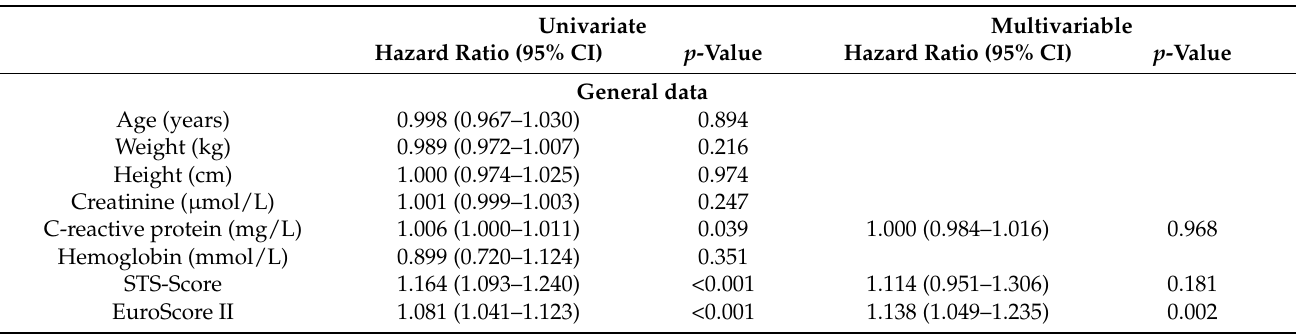
Figure 2. Kaplan–Meier curves of 30-days mortality in patients with severe AS. ( A ) Comparison of non-PH vs. PH; ( B ) comparison of non-PH and different PH subtypes; ( C ) univariate Cox regression analysis of different PH subtypes. Prec-PH: pre-capillary pulmonary hypertension; Ipc-PH: isolated post-capillary pulmonary hypertension; borderlinepc-PH: borderline post-capillary pulmonary hypertension; Cpc-PH: combined post- and pre-capillary pulmonary hypertension. Table 2. Univariate and multivariable predictors of 1-year survival in pulmonary hypertension due to severe